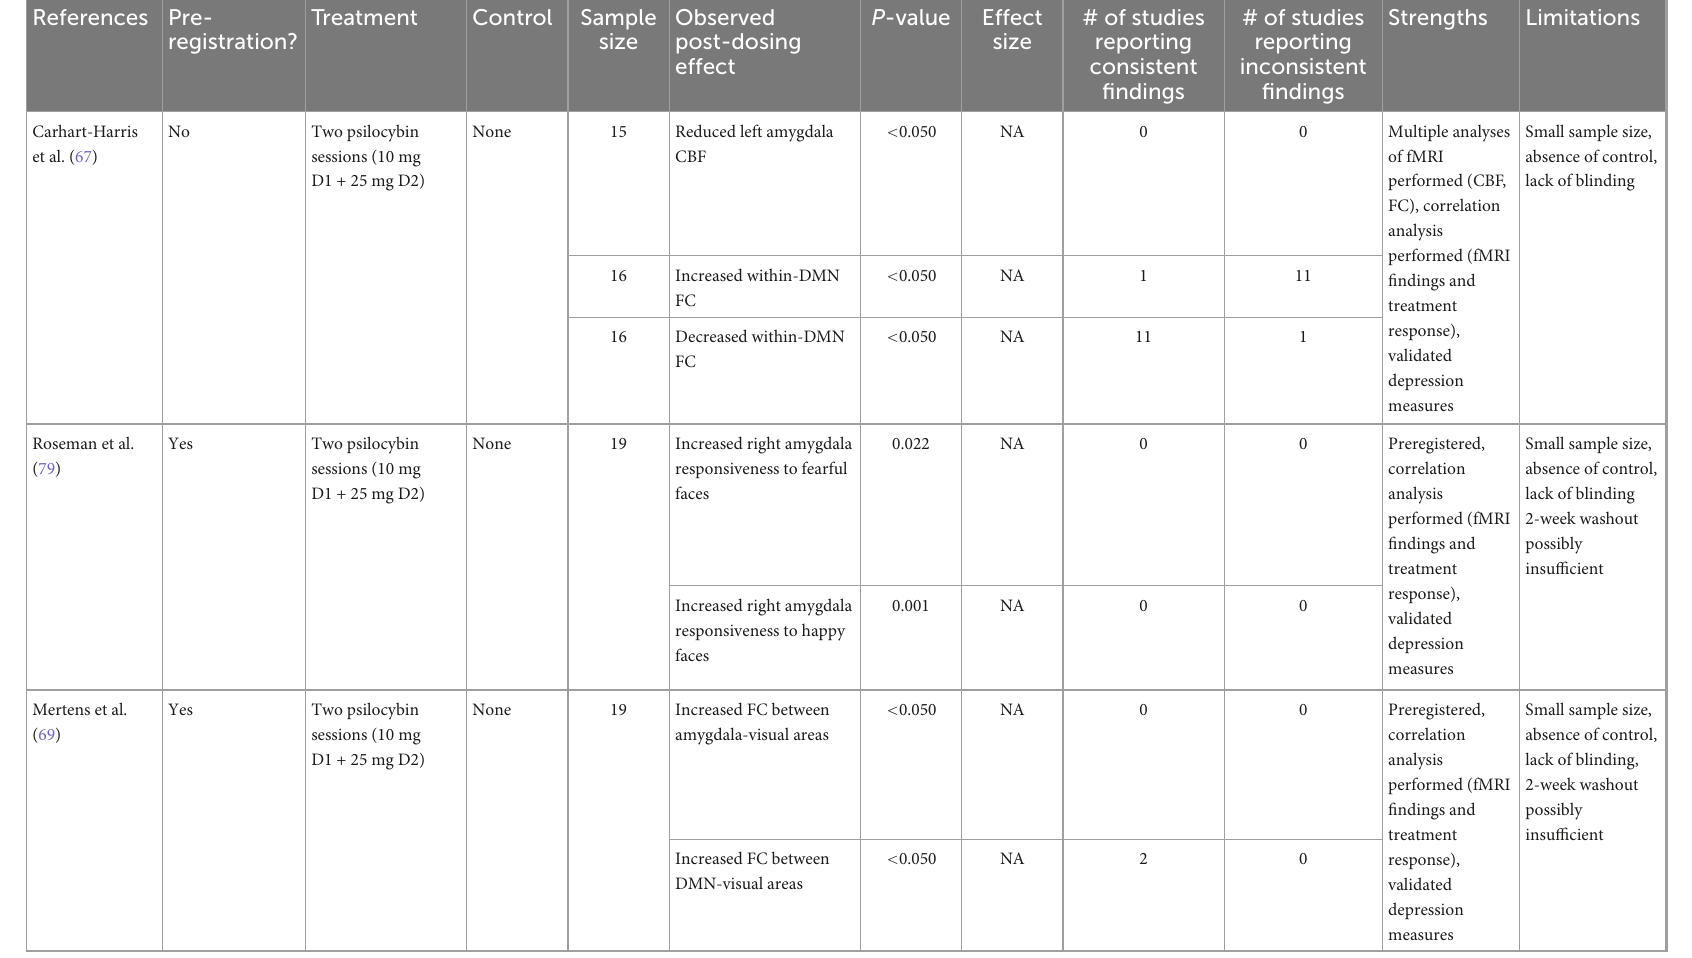
TABLE 1 Summary of neuroimaging